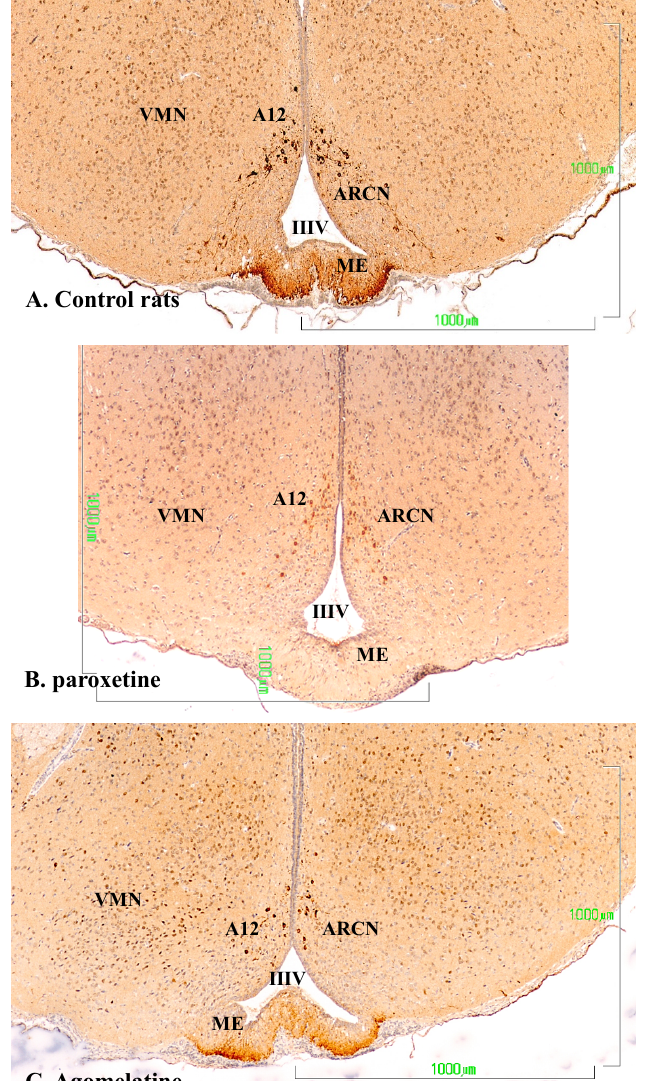
Figure 6. Hypothalamus